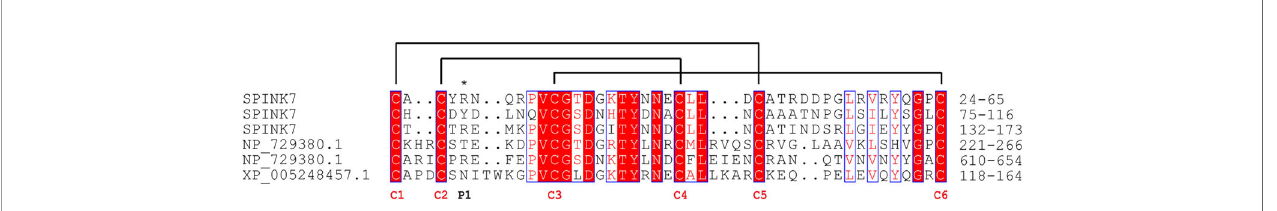
FIGURE 1 | Sequence alignment of SPINKs from Bombyx mori , Drosophila melanogaster and Homo sapiens . B. mori SPINK7, GenBank accession No. XP_004924430.1; D. melanogaster SPINK, GenBank accession No. NP_729380.1; H. sapiens SPINK, GenBank accession No. XP_005248457.1. The conserved cysteine residues and reactive sites are indicated with red “ C ” and an asterisk, respectively. Disul fi de linkages are indicated with